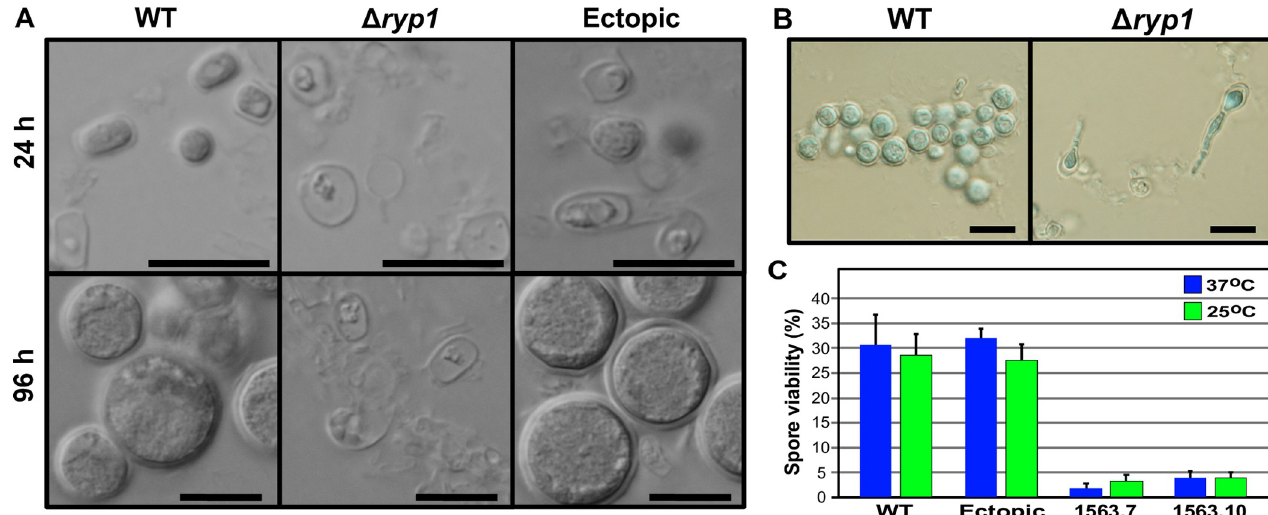
Fig 2. C . posadasii Δ ryp1 does not produce normal spherules in vitro . (A, B) Spherules of WT, a Δ ryp1 mutant and an ectopic transformed strain, grown in Converse medium at 37˚C with 20% CO 2 and aliquots analyzed during in vitro spherulation. (A) Images at 24 h show that while the WT and ectopic strains are rounding up to form early spherules, Δ ryp1 does not form round structures. At 96 h, the WT and ectopic strains produced mature spherules, while the Δ ryp1 exhibited limited polar hyphal growth. (B) Images stained with lactophenol blue at 120 h show mature spherules produced by WT and polar hyphal growth by Δ ryp1 . Black bars represent 10 μ m. (C) Percentage of spore viabilities for WT and ectopic strains, and Δ ryp1 mutants (1563.7 and 1563.10) were determined based on the growth on 2X GYE plates at 37˚C and 25˚C.